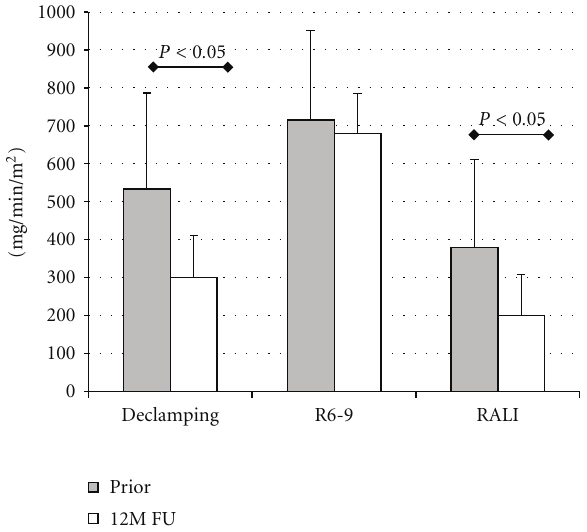
Figure 1: Objective (gravimetry) intensity of abdomino-lumbar sweating measure prior to intervention and 12 months after it. Comparisons in paired t -Student